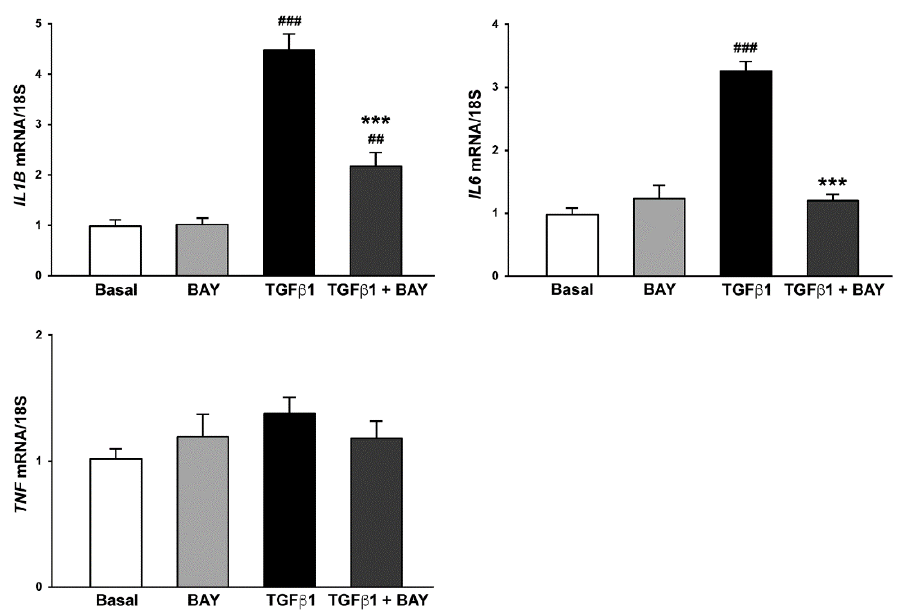
Figure 9. The soluble guanylate cyclase stimulator BAY 41-2272 significantly reduces TGF β 1-induced expression of genes encoding proinflammatory cytokines in human keratocytes. Gene expression of IL1B (gene encoding interleukin 1 β ), IL6 (gene encoding interleukin 6), and TNF (gene encoding tumor necrosis factor α ) was evaluated by real-time PCR. The basal level of each gene expression was set to 1, and the other results are normalized to this value; 18S ribosomal RNA was used as reference gene. Bars represent the mean ± SEM of triplicate determinations from five cell lines. ## p < 0.01, ### p < 0.001 vs. basal condition, *** p < 0.001 vs. TGF β 1 alone (Tukey’s test). SEM, standard error of the mean; TGF β 1, transforming growth factor β 1.